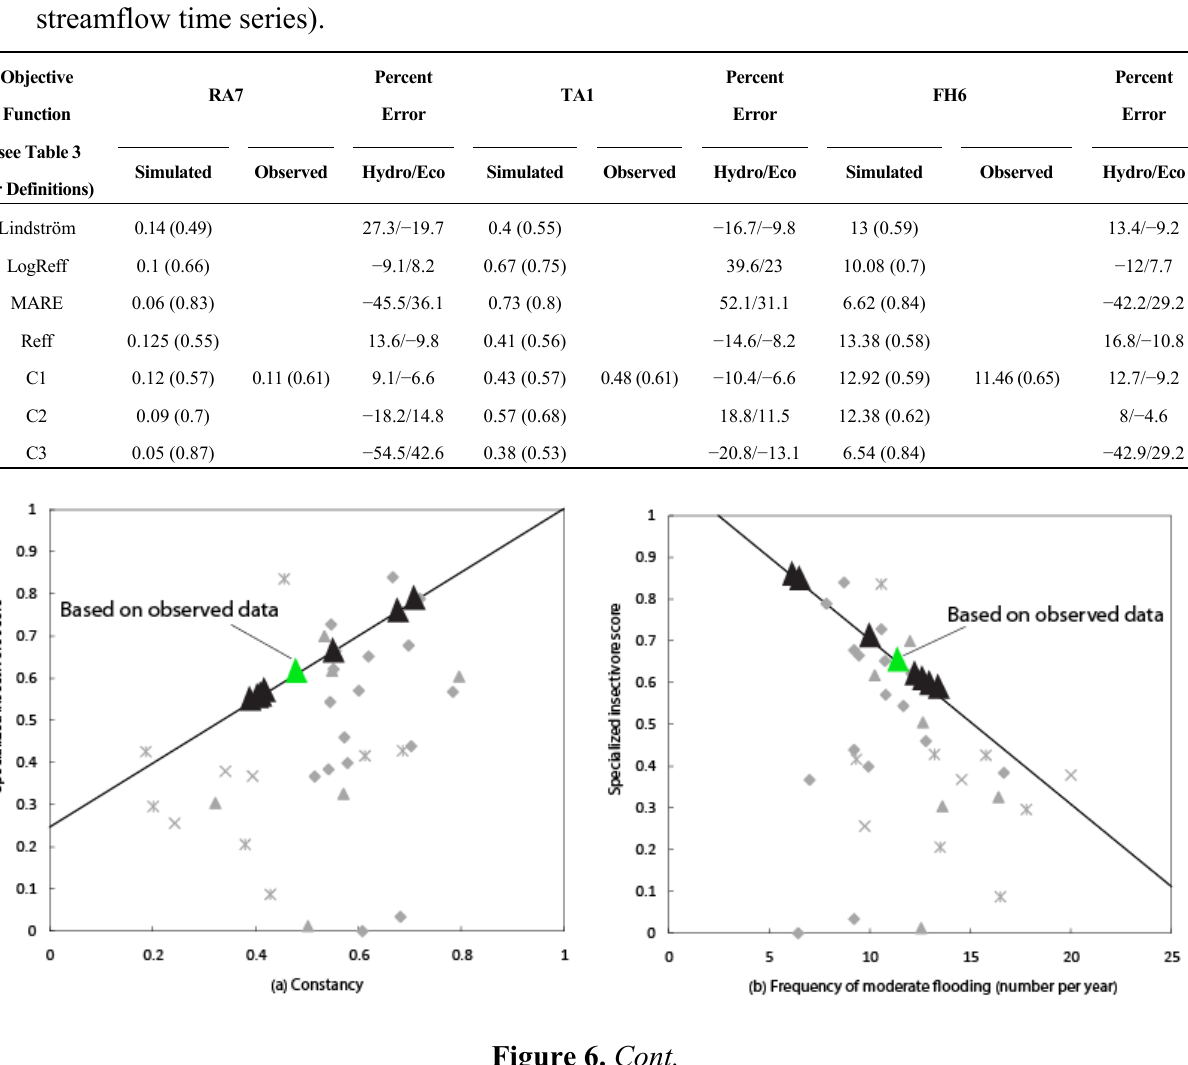
Table 9. Comparison of selected streamflow characteristics based on simulated and observed streamflow time series for a single model location (site 13 (03488000)) and calibration period 1 (Cal1). (TA1, RA7, and FH6, defined in Table 5; values in parentheses represent the specialized insectivore score using the associated streamflow characteristic value based on linear equations presented in Knight et al. [41], Figure 2; hydro, percent error for streamflow characteristic derived from simulated and observed streamflow time series; eco, percent error for specialized insectivore score based on streamflow characteristic derived from simulated and observed streamflow time